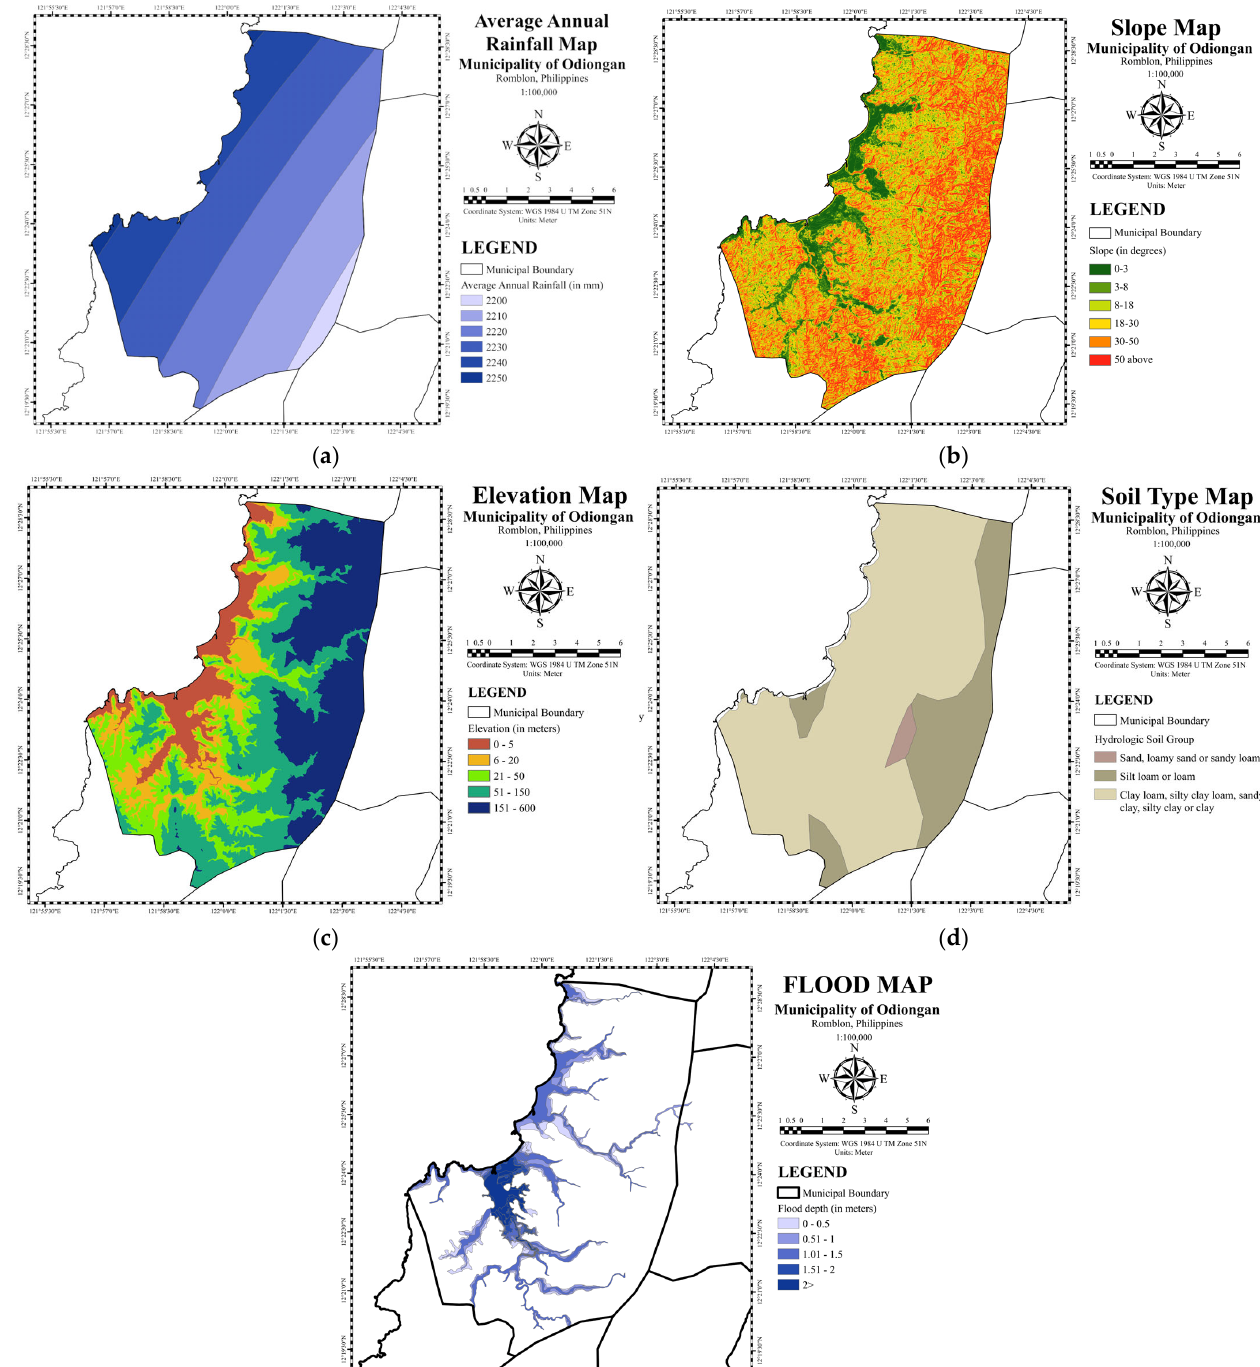
Figure 3. Maps generated using ArcGIS in flood hazard parameters: ( a ) Average Annual Rainfall Map; ( b ) Slope Map; ( c ) Elevation Map; ( d ) Soil Type Map; and ( e ) Flood Depth map of Odiongan, Romblon.